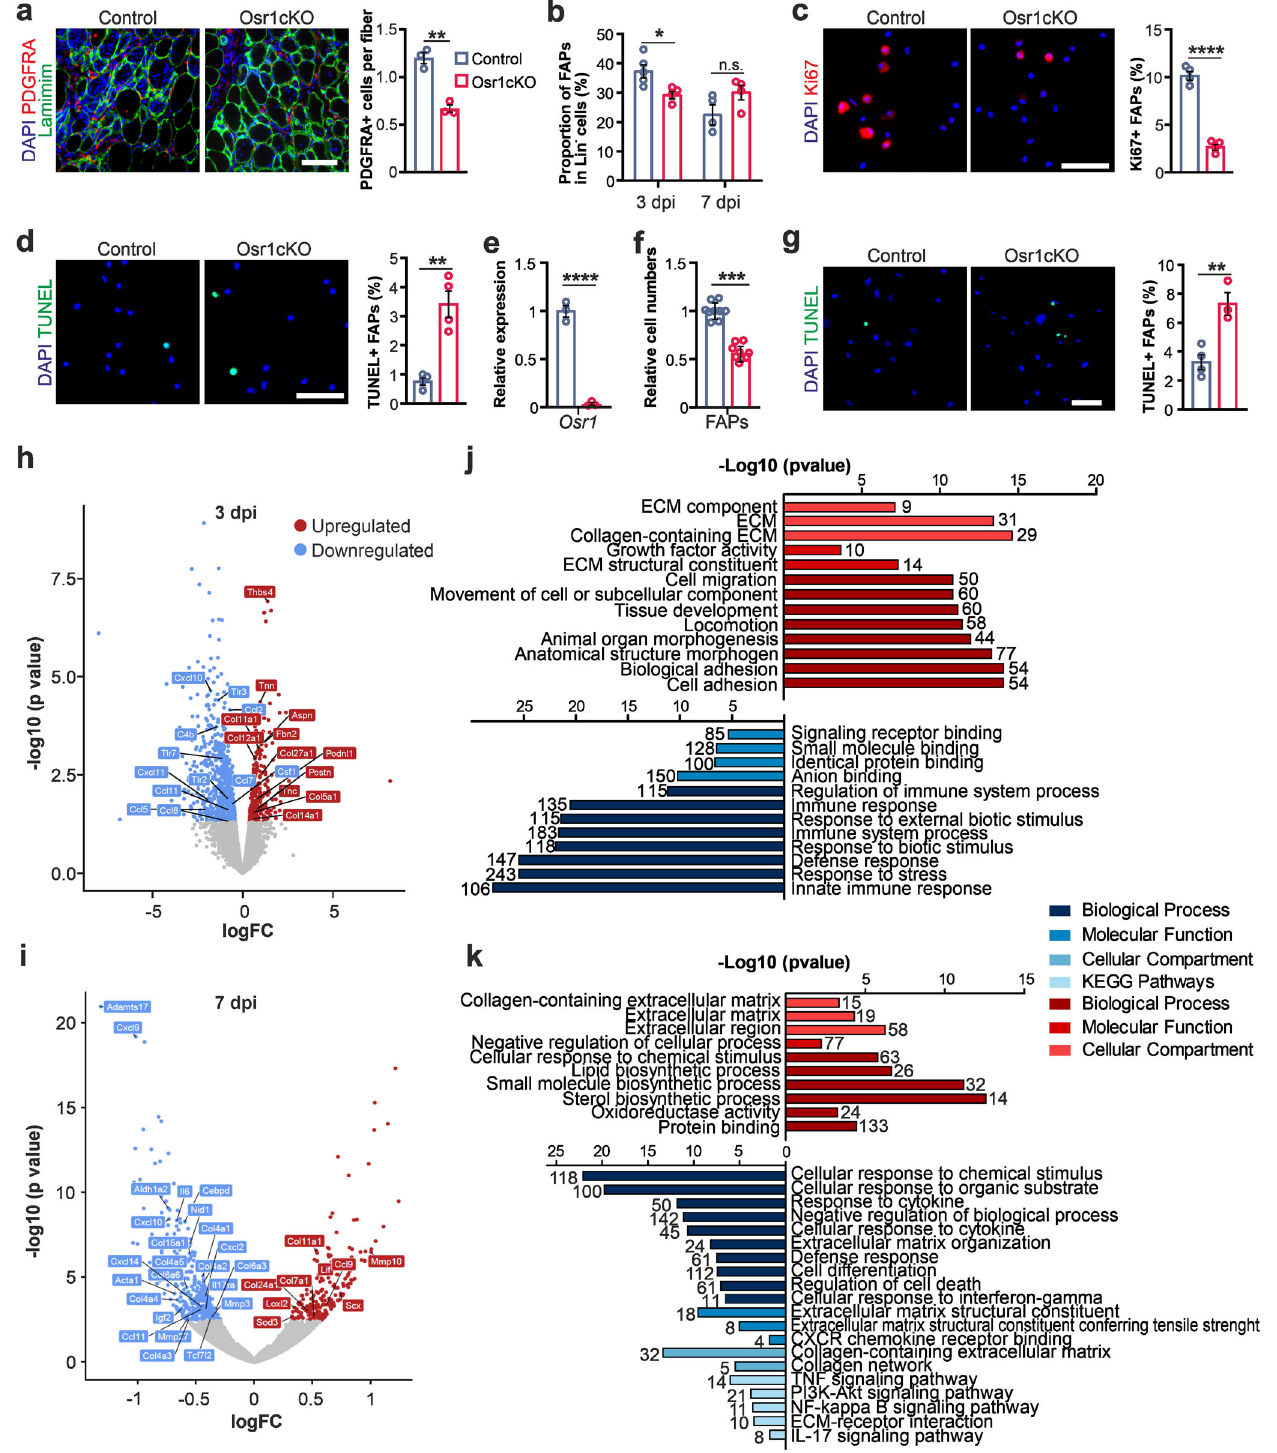
cells, but not NKT cells, were found in 3 dpi Osr1cKO muscles (Fig. 4e). No signi fi cant differences in the relative overall numbers of macrophages, neutrophils or dendritic cells (Fig. 4f, Supple- mentary Fig. 5c), or dendritic cell subsets (Supplementary Fig. 5f) were detected between Osr1cKO and control 3 dpi muscles. This together argues against a global effect of Osr1 depletion in FAPs on immune cell in fi